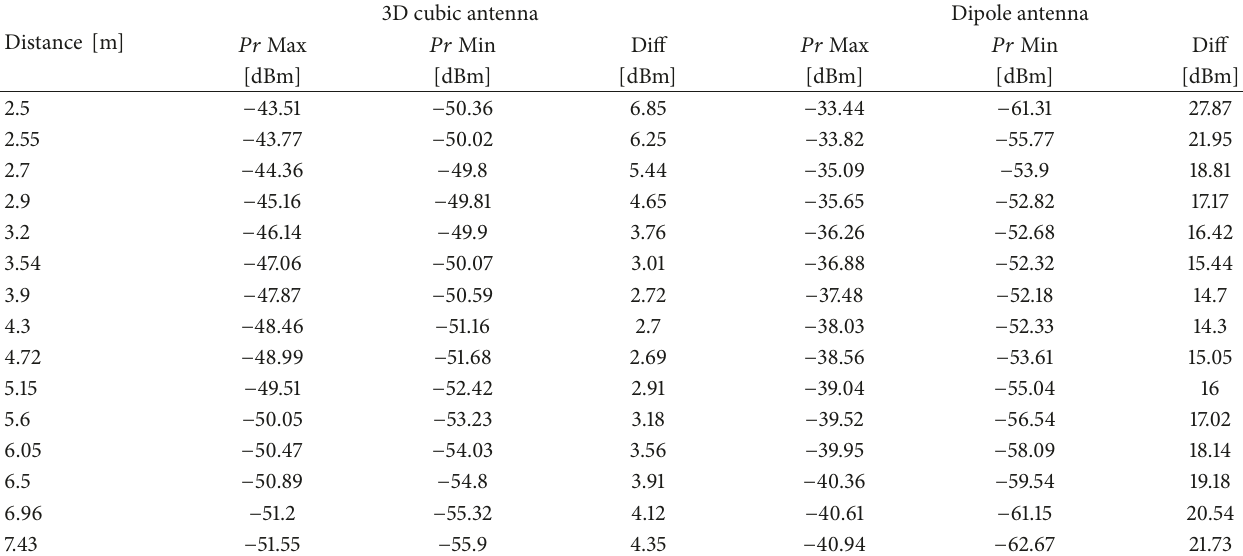
Table 3: Difference between 𝑃𝑟 Max and Min in the LOS